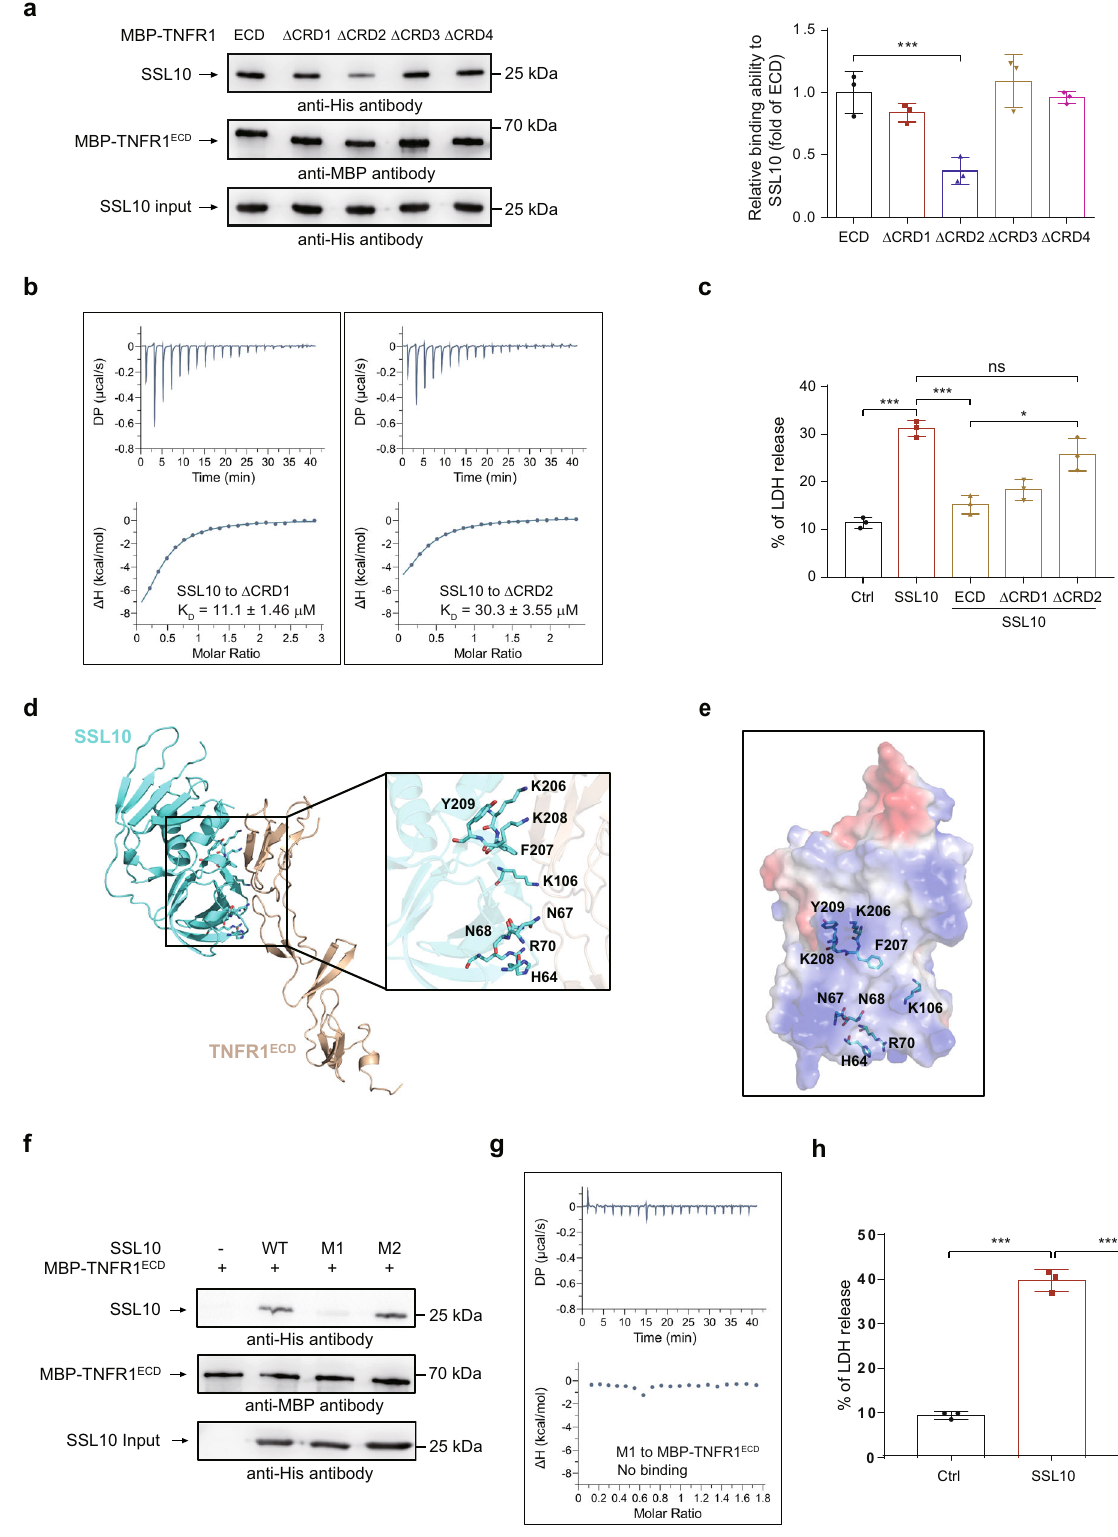
signal before luminescence being recorded with BioTek Synergy/2. Luminescent signals from blank wells and buffer-treated cells were used as background and maximal luminescence. Cell death detected by fl ow cytometry was performed as previously described 50 . Brie fl y, 48h after treatment with SSL10, the cells were collected and washed twice with ice-cold PBS. The cells were then incubated with 5 μ l FITC annexin V and 5 μ l PI in 500 μ l prepared assay buffer in dark for 10 min at room temperature,